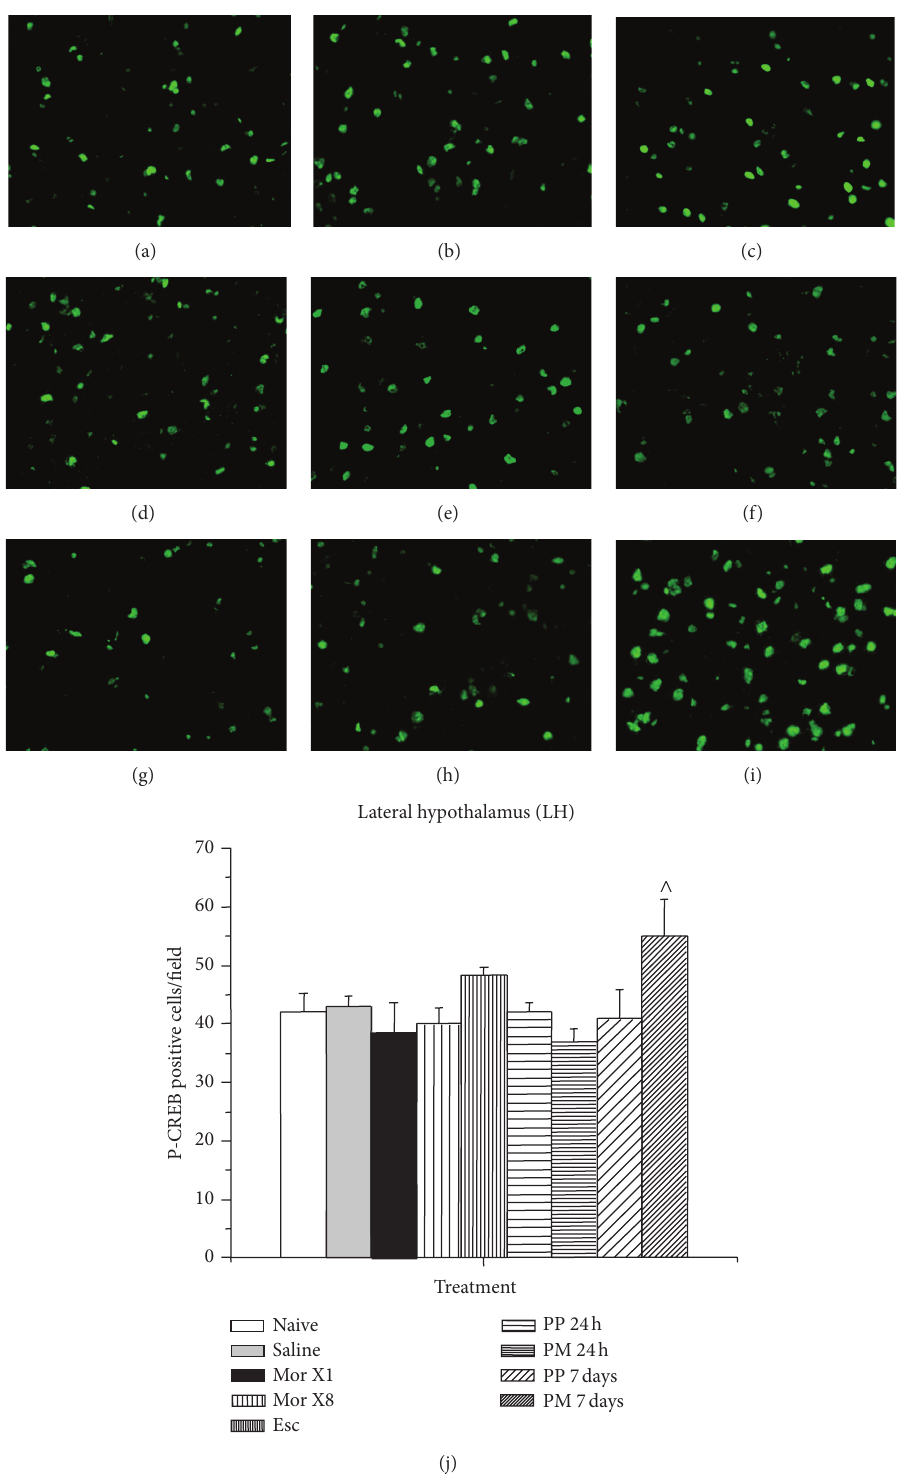
Figure 3: Changes in P-CREB staining in the LH following different morphine treatments ((a) group 1, na¨ıve; (b) group 2, saline; (c) group 3, MorX1; (d) group 5, MorX8; (e) group 6, Esc; (f) group 7, PP24h; (g) group 8, PM24h; (h) group 9, PP7d; (i) group 10 PM7d) as determined by immunofluorescence (200X). Quantification of P-CREB (j). See Table 1 for details on the morphine treatment paradigm. 𝑁 = 6 – 9 per treatment. ∧ 𝑃 < 0.05 versus 7 d placebo